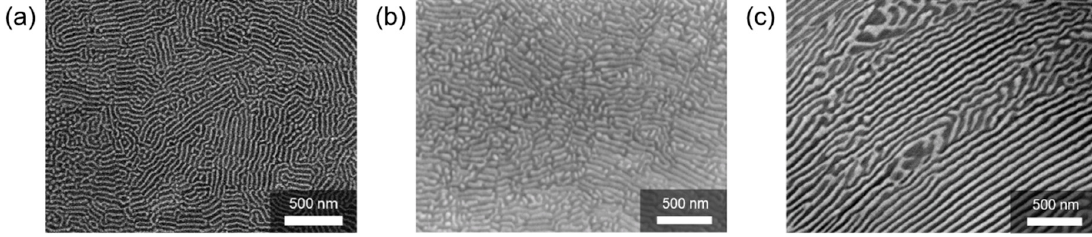
Figure 4. Scanning electron microscopy (SEM) images of nano-lamellar structures obtained by MS at